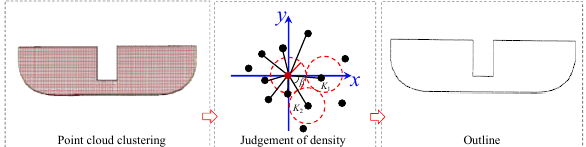
Figure 6. Schematic diagram of the outline extraction